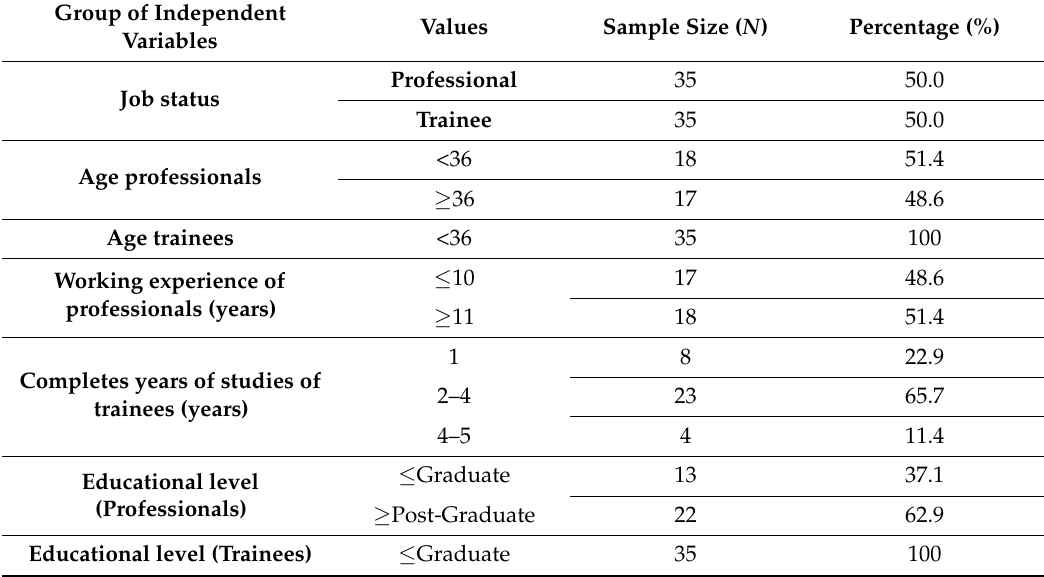
Table 2. Research